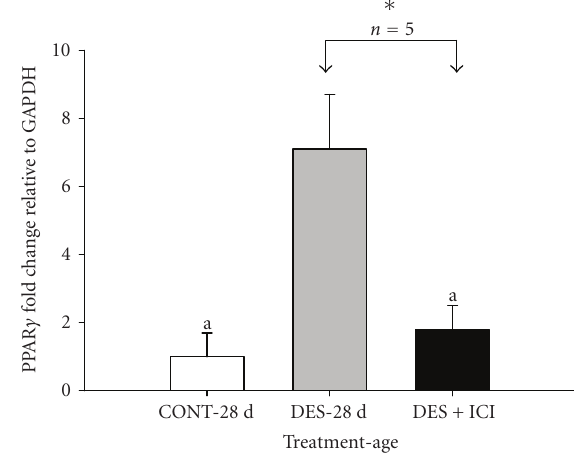
Figure 4: Real-time PCR data showing attenuation of the e ff ect of DES on PPAR γ mRNA by ER blocker ICI 182, 780 in 28-day-old rats treated neonatally with either 25 μ L of olive oil (CONT-28 d), oil containing DES (DES-28 d; 0.1mg/kg bw), or DES plus ICI (DES + ICI; 16.6 mg/kg). ICI treatment significantly inhibited DES-induced PPAR γ mRNA [DES-28 d versus DES + ICI]. Comparison between control and DES treated rats showed 7.1 fold increase in expression [CONT-28 d versus DES-28 d]. Letter [a] indicates no significant di ff erences between CONT-28 d and DES + ICI. Data ( n = 5) are expressed as mean ± SE. ∗ P < . 05.